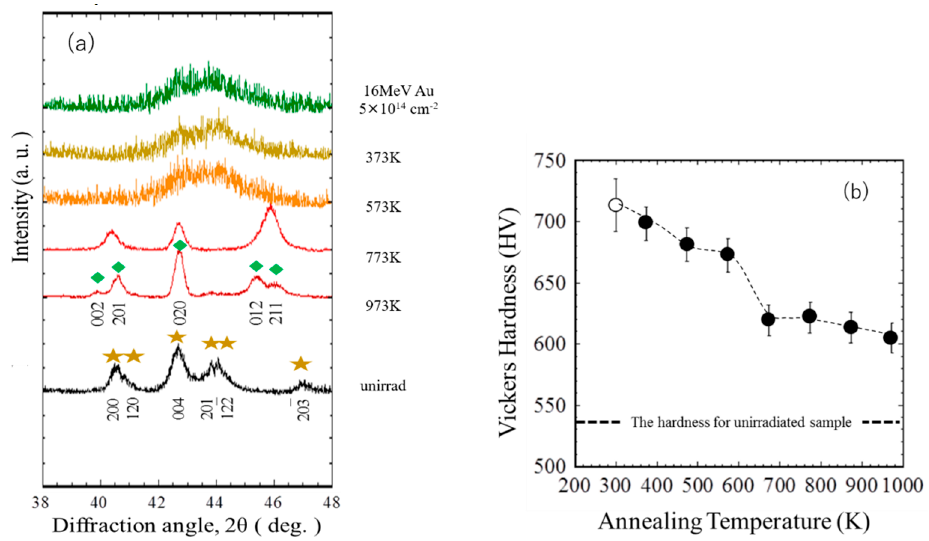
Figure 30. Effect of thermal treatment of Ni 3 Ta for ( a ) GIXD spectra and ( b ) Vickers hardness. Thermal treatment temperatures are shown at the right side of Figure 30a. The open circle in Figure 30b indicates the hardness value before thermal treatment. Hardness for the unirradiated specimen is also shown in Figure 30b.